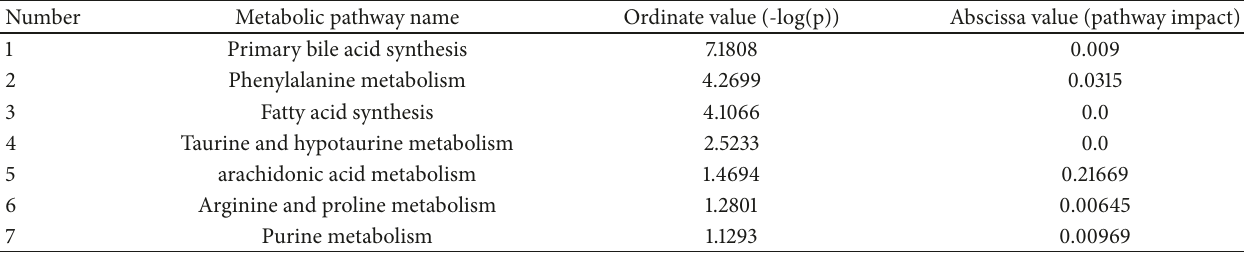
Table 12: Metabolic pathway name and distribution